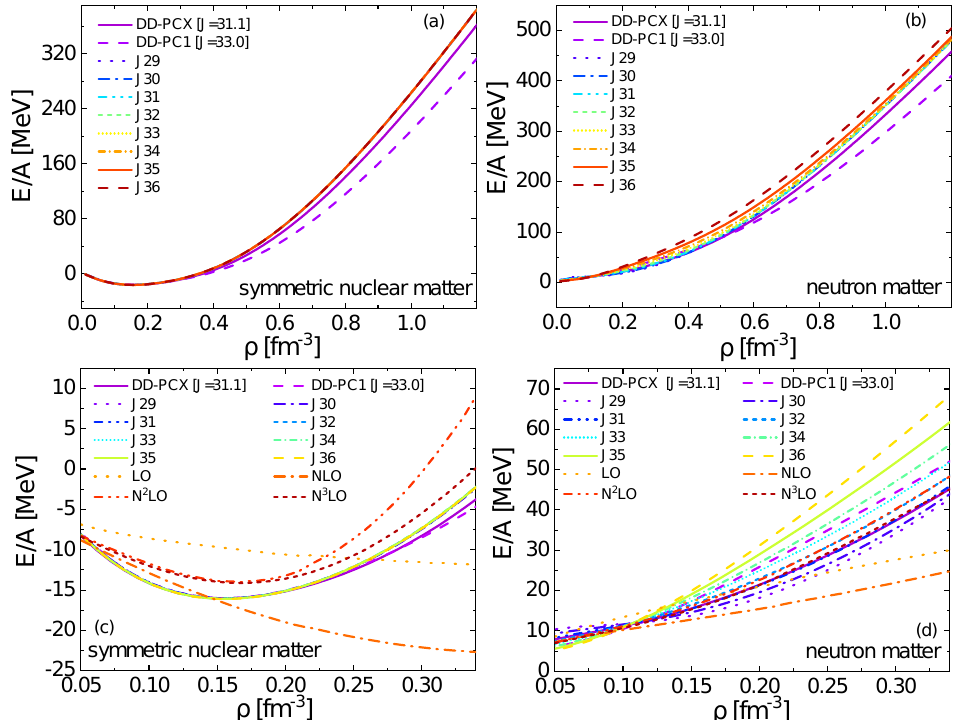
Figure 1. Equation of state of symmetric nuclear matter ( a ) and pure neutron matter ( b ) using the family of point-coupling functionals spanning the range of symmetry energy at saturation J = 29–36 MeV. The results are also presented using the DD-PC1 and DD-PCX functionals, and the symmetry energy values of the functionals are given within the square brackets in units of MeV. Panels ( c , d ) are the same, but the results are displayed up to the density 0.34 fm − 3 to compare with the predictions from chiral effective field theory ( χ EFT) (see Reference